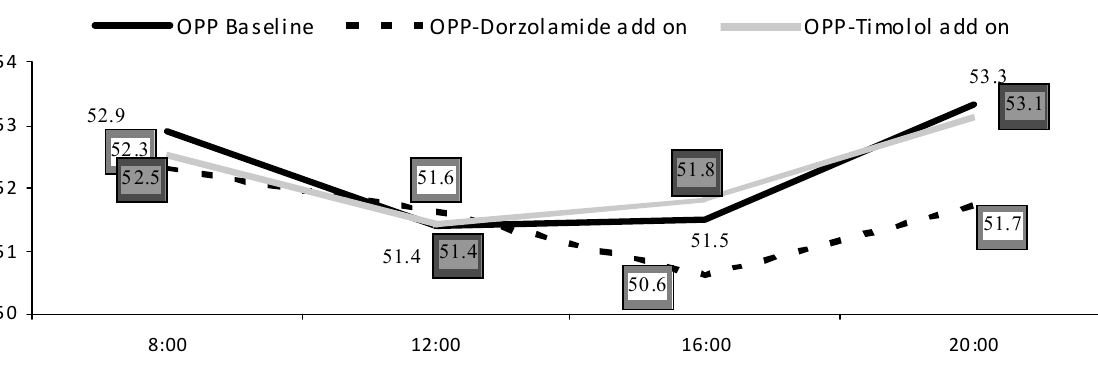
Figure 2. OPP diurnal fluctuations